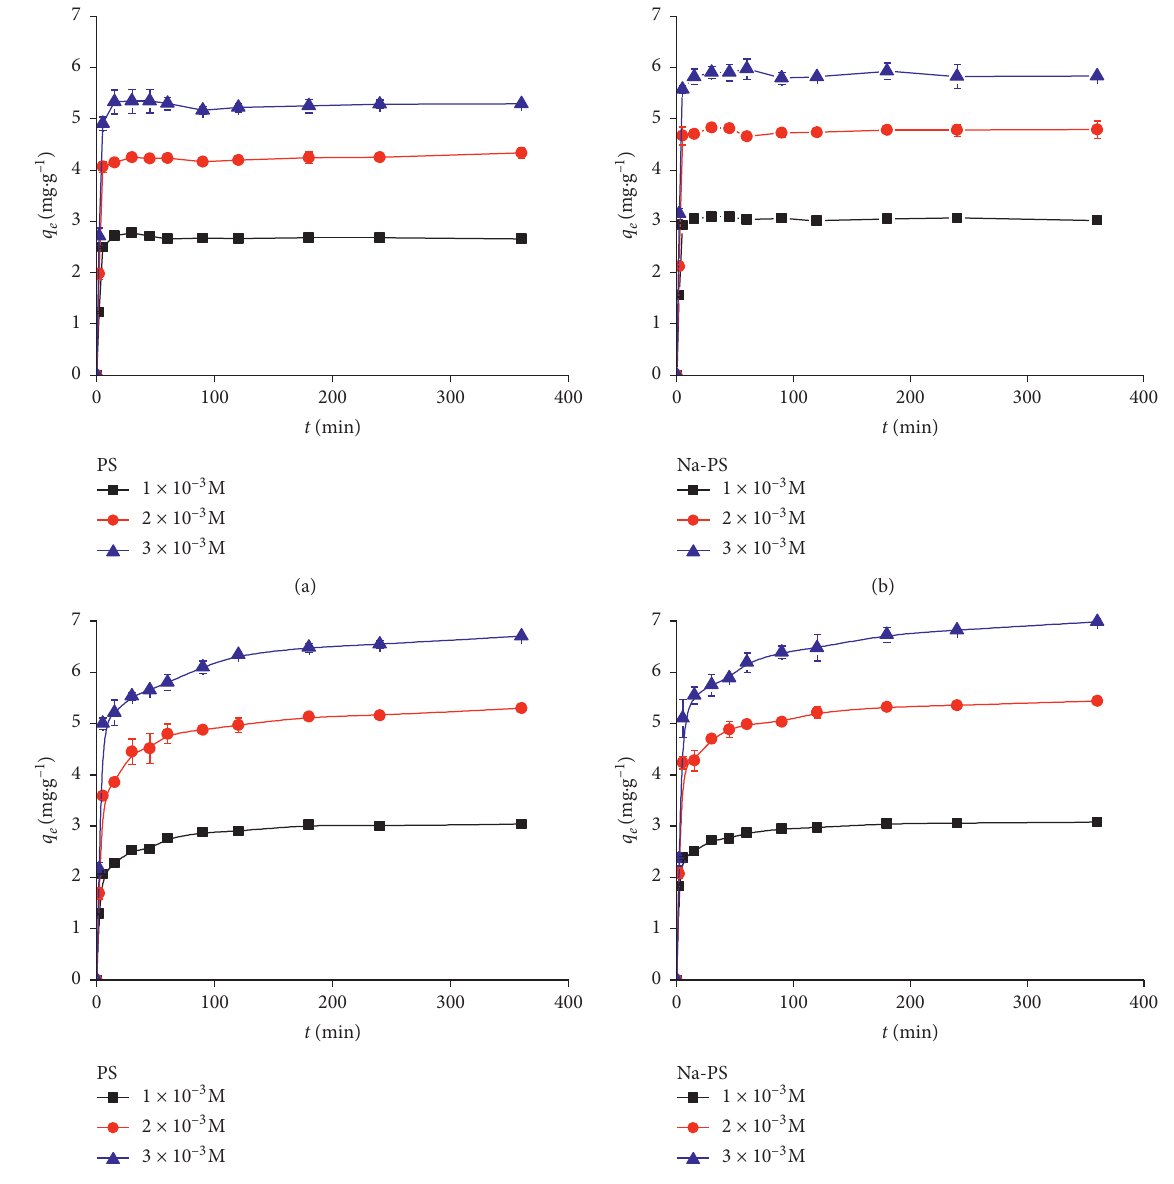
Figure 3: Effect of the agitation time on Cd(II) (a and b) and Cu(II) (c and d) adsorption on PS and Na-PS depending on the initial concentration. Note: PS means Pisha sandstone; Na-PS means Pisha sandstone modified with Na + Figure 5. Fitting the isotherm with the Langmuir model, the maximum adsorption capacities ( q ) of Cd(II) and Cu(II) m were 12.79 and 19.49 mg · g − 1 for PS, respectively. Na + - modified PS effectively increased the Cd(II) and Cu(II) sorption amounts (12.81 and 21.37 mg · g − 1 , respectively). The selective adsorption of the PS adsorbents to Cd(II) or Cu(II) was dependent on the electronegativity and the hydrated ionic radius [46]; higher electronegativity and hydrated ionic radius exhibited better metal uptake [47, 48]. In addition, compared with other adsorbents such as kaolinite and bentonite (6.8 and 10.8 mg · g − 1 for Cu(II) and 4.4 and 11 mg · g − 1 for Cd(II), respectively) [24, 25, 41, 49], the PSs